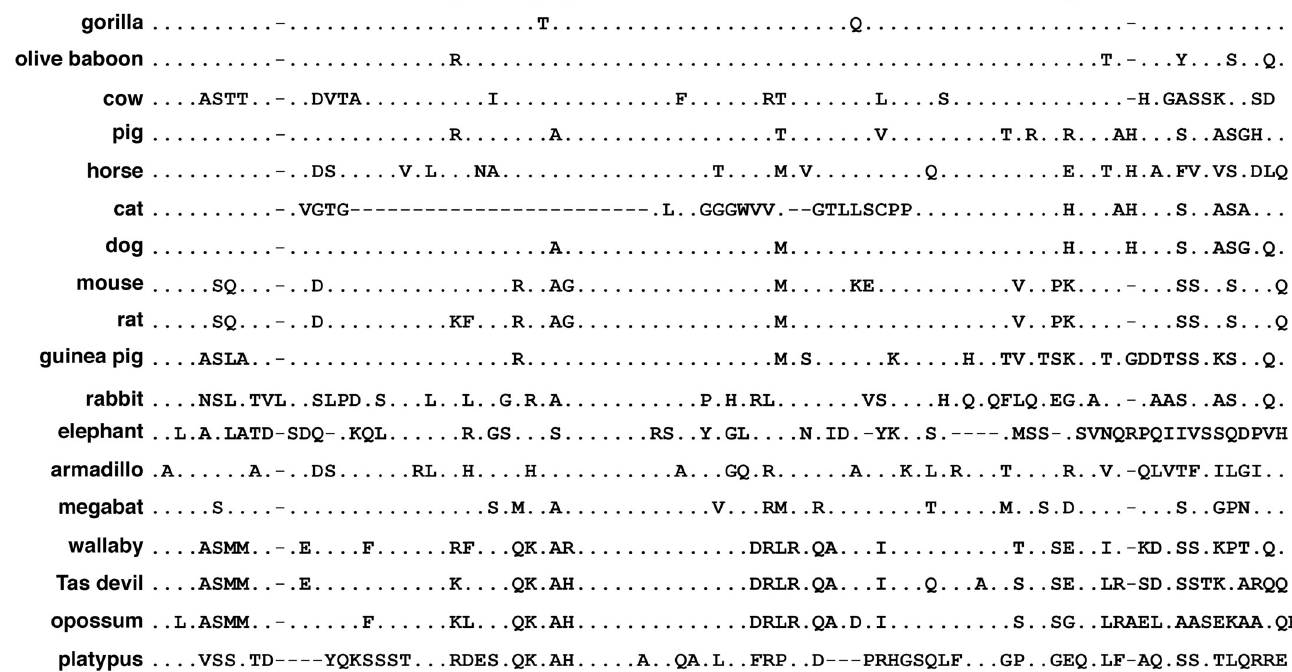
Fig 9. Alignments of IGF2 E peptides. Amino acid sequences of COOH-terminal IGF2 E peptides from 19 mammals are depicted in single letter code. Dots indicate identities, dashes depict no residues, and differences among species are shown. The IGF2 E domain comprises different lengths, ranging from 64 (cat) to 91 (opossum) amino